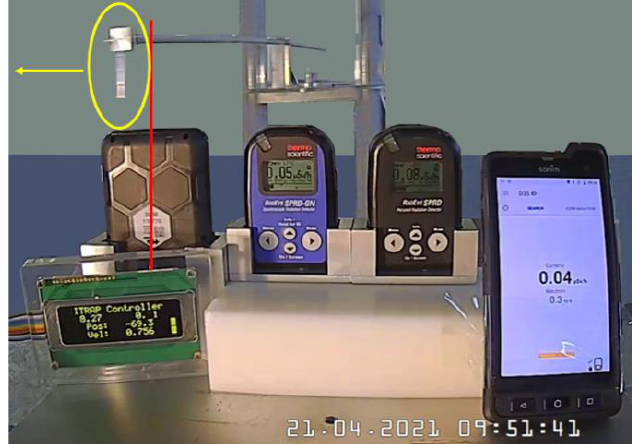
Fig. 5. The source is marked with the yellow ellipse, it is moving in the direction of the yellow arrow. The D3S from Kromek as well as two RadEYE devices from Thermo are tested. Below the source the control display is placed. The red line indicates the zero